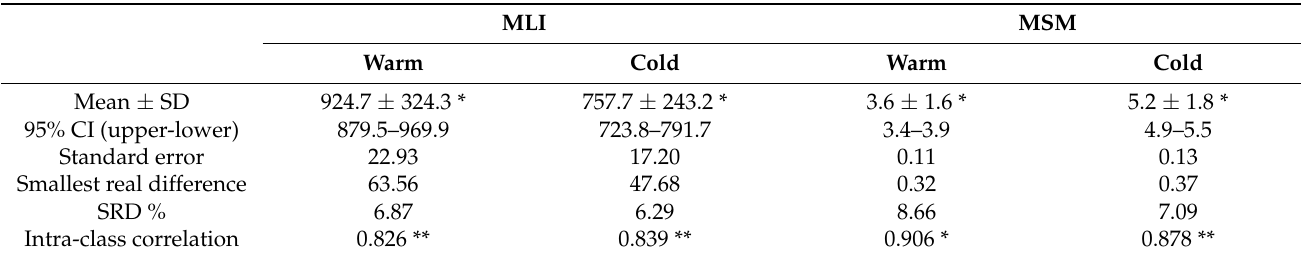
Table 1. Mean absolute thermal sensitivity, reliability, and reproducibility between the method of limit and method of sensation magnitude.